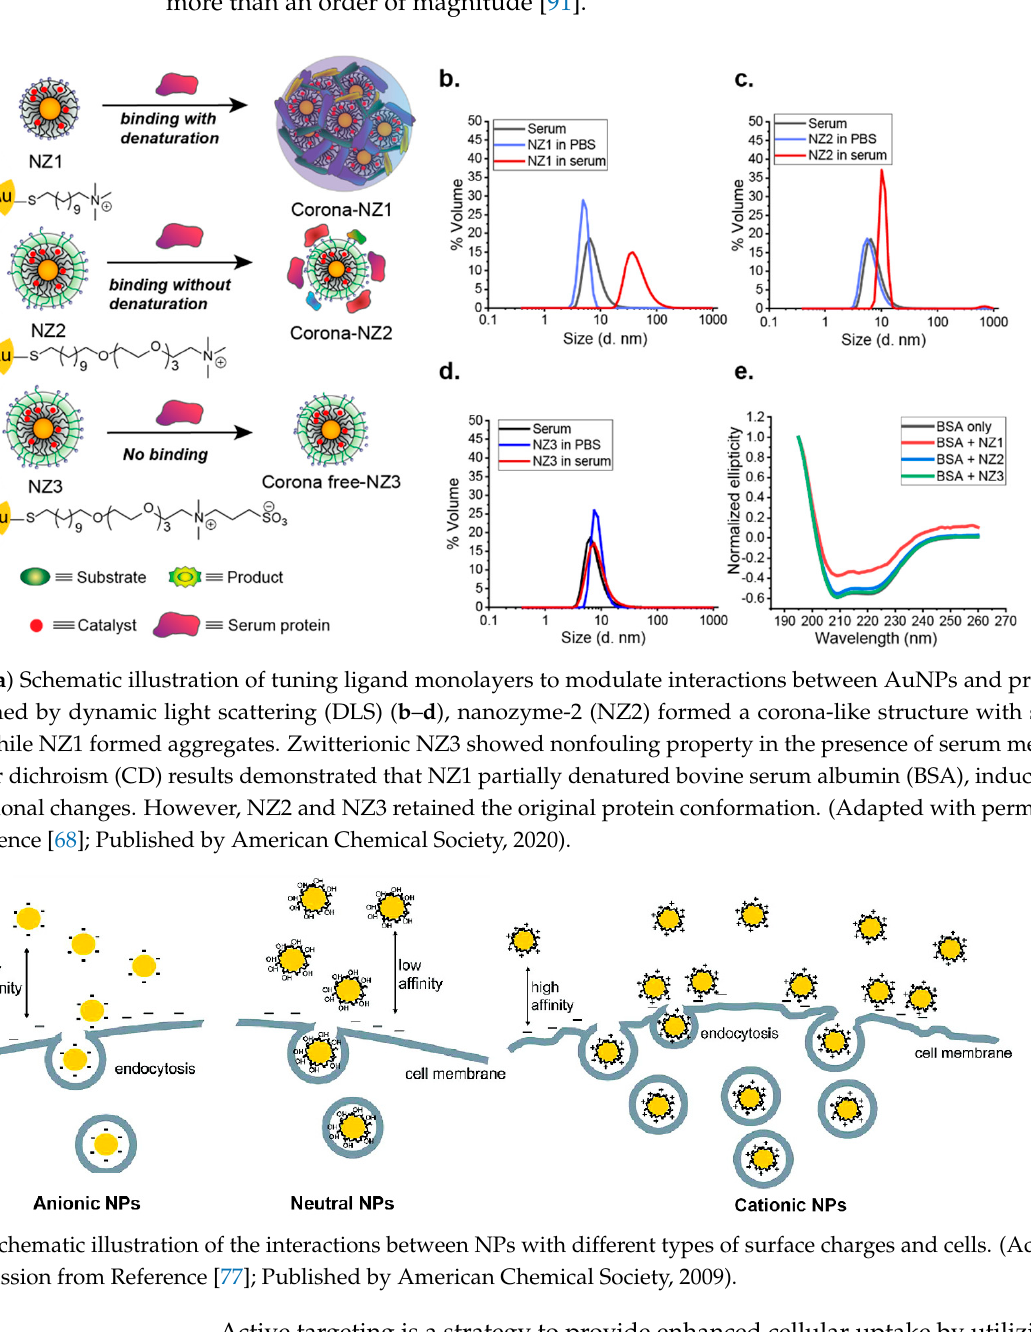
Figure 4. Schematic illustration of the interactions between NPs with different types of surface charges and cells. (Adapted with permission from Reference [77]; Published by American Chemical Society, 2009). Based on this electrostatic property, a wide range of NPs have been engineered to carry positive charge for their enhanced cellular internalization [80–87]. Additionally, surface charge modification can also be used to dictate either extra- or intracellular lo- calization of NPs [75]. Rotello noncovalently incorporated dyes or drugs into zwitterionic